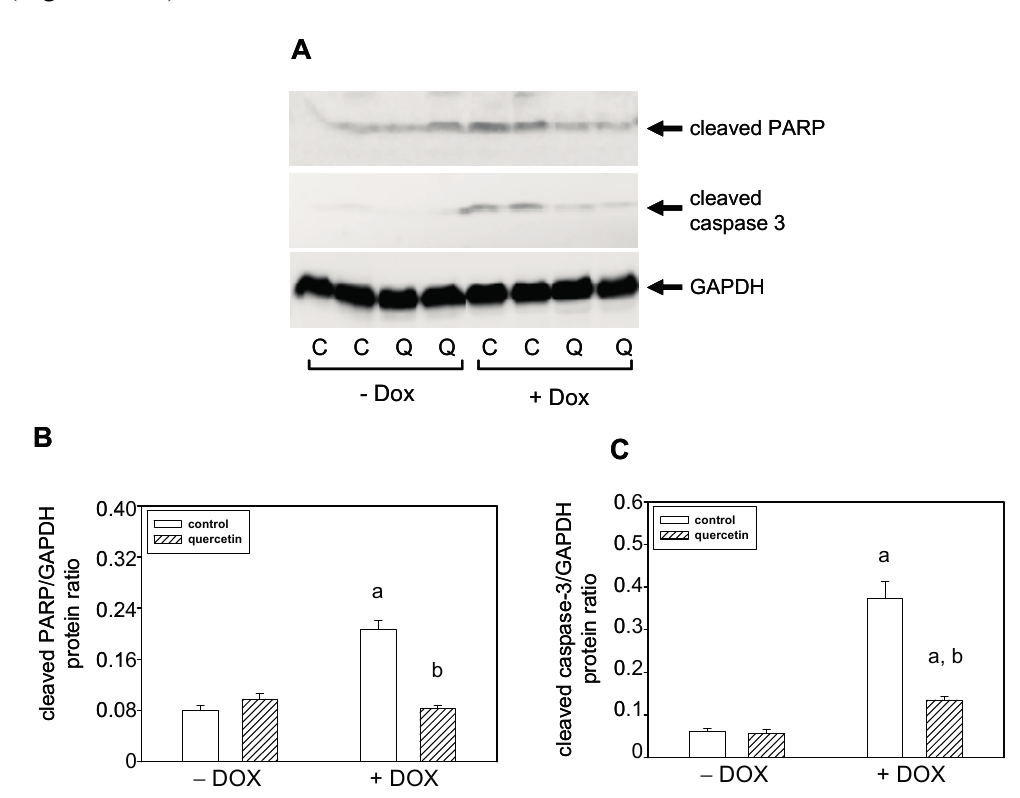
Figure 4. Effect of QCT and DOX on markers of apoptosis induction in the left ventricle. ( A ) The protein levels of cleaved caspase-3 and cleaved PARP were determined by western blot analysis using specific antibodies. The protein loading is documented using GAPDH; ( B ) Quantification of cleaved caspase-3 content normalized to the GAPDH protein levels; ( C ) Quantification of cleaved PARP content normalized to the GAPDH protein levels. Data were obtained from western blot records and each bar represents mean ± S.E.M. of seven tissue samples per group. Statistical significance is revealed by Student’s unpaired t -test, a p < 0.05 vs. control saline-treated ( − DOX) rats; b p < 0.05 vs. DOX-treated (+DOX)